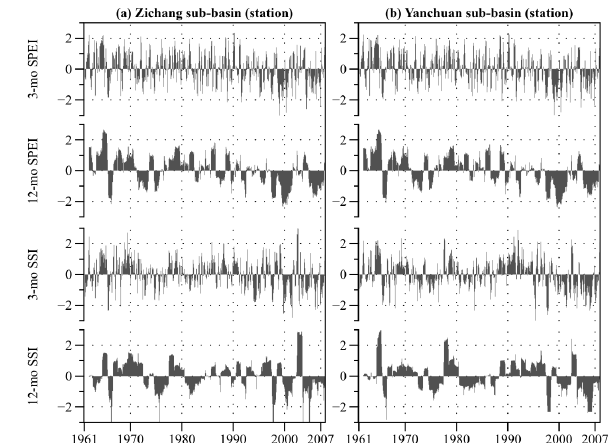
Figure 4. Evolution of 3-month and 12-month SPEI and SSI during the period of 1961–2007.